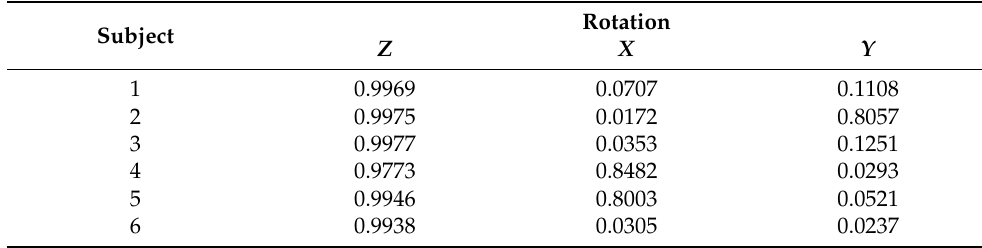
Table 5. Cross-correlation for the difference of rotations. Each group of curves is compared between them to analyze the similarity for each